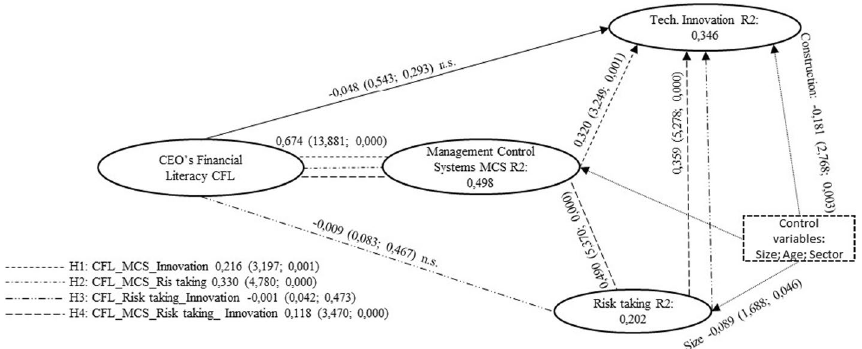
Fig. 2 Structural model results